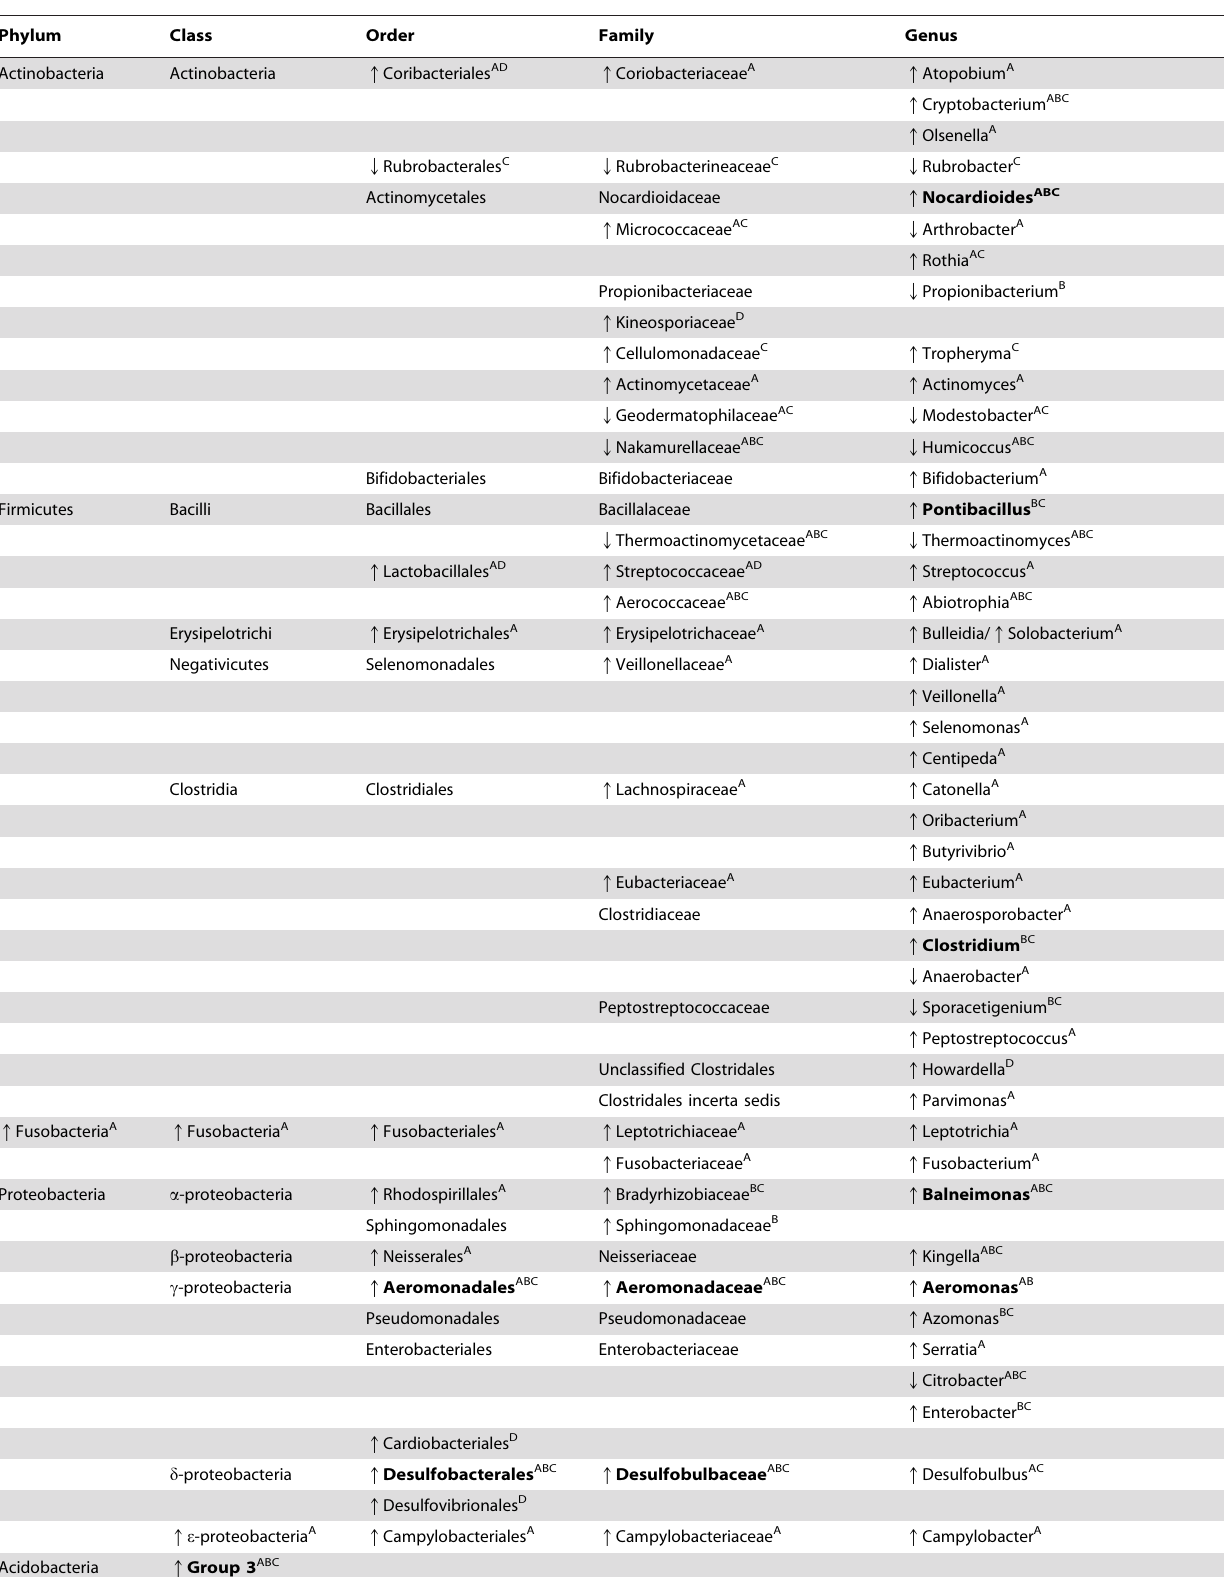
Table 2. Metastats Analysis of Differential